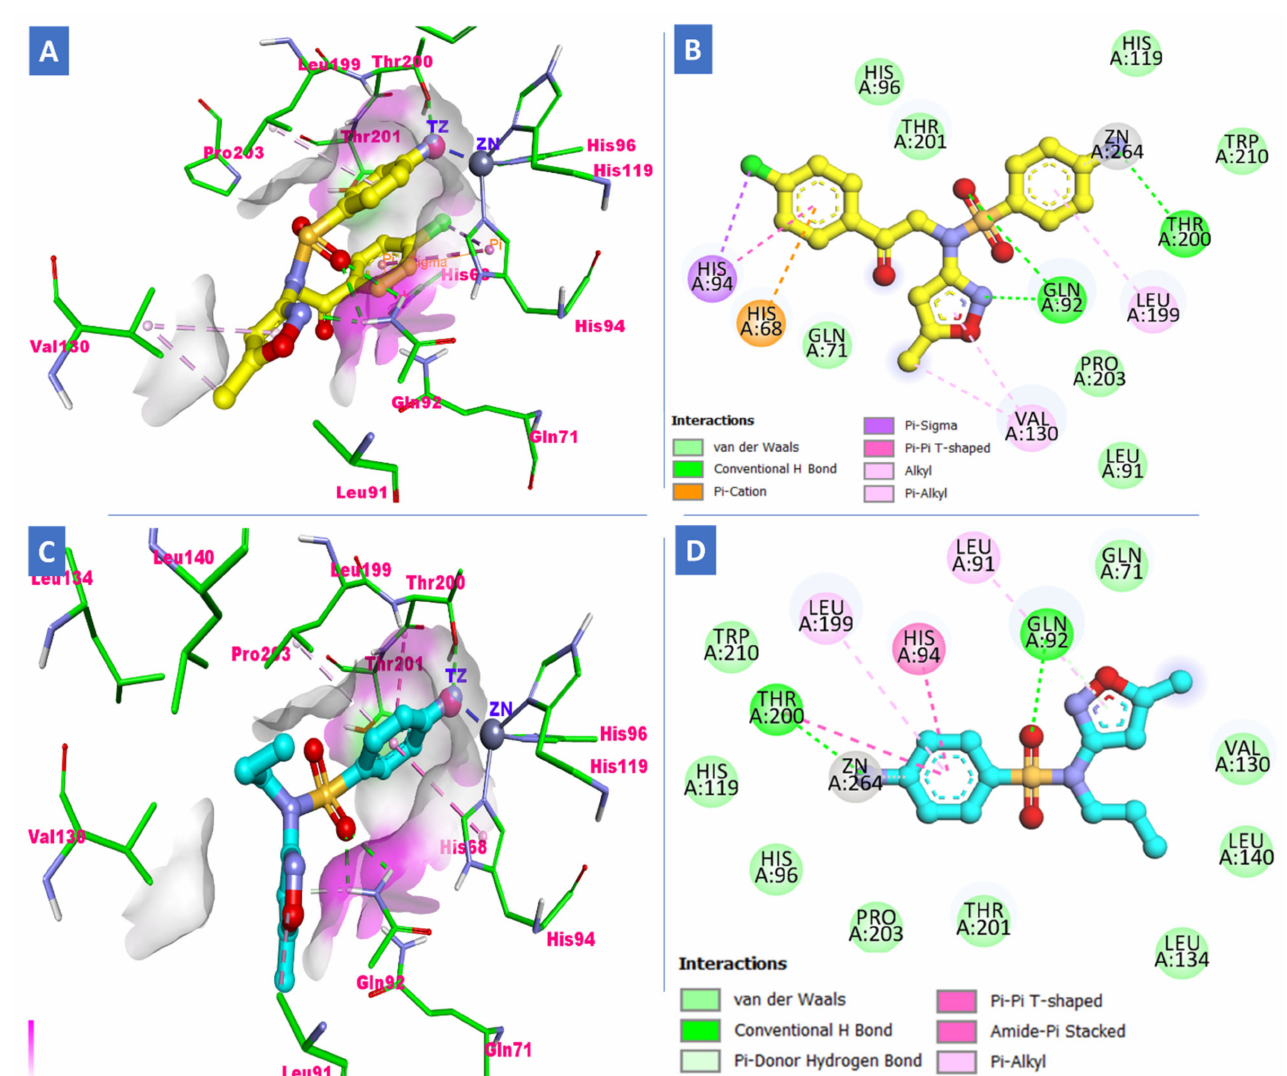
Figure 8. The docking results and interactions of compounds S15 (yellow) and S3 (cyan) into the active site of hCA-IX isoenzyme (PDB code: 5FL4); ( A , B ) 3D and 2D binding modalities of S15 , respectively; ( C , D ) 3D and 2D binding modalities of S3 , respectively. The docked poses were displayed in ball & stick style. Zn atom was shown as a blue ball while pseudoatom TZ was represented as a pink ball. Favorable co-ordinate bond with Zn cation, hydrogen bonds and π - Stacking were showed in dashed blue, green and orange dashed lines, respectively. Hydrogen bond surfaces around docked pos-es were created. Hydrogen atoms were omitted for clarity